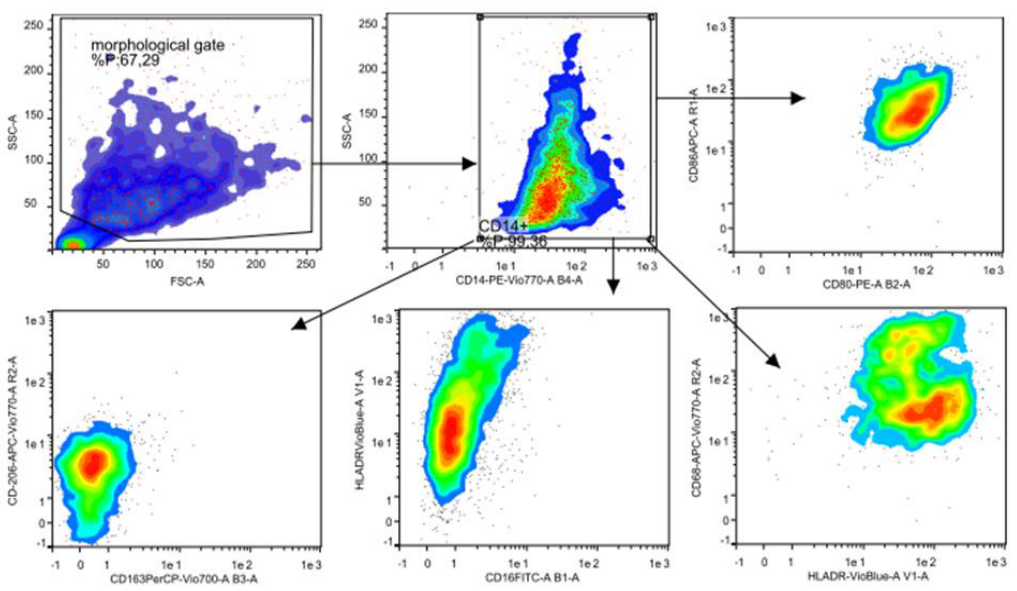
Figure 4. Gating strategy used for the analysis of M1 and M2 phenotype. For the analysis of human macrophage differentiation phenotype, cells were harvested and analyzed by flow cytometry. Morphological gating (top left) was used to exclude cell debris from analysis. The CD14+ monocyte differ from CD14-, in order to identify macrophages, CD14+ cells were identified (top middle). Next, CD14+ cells were analyzed for their expression of CD80 and CD86 (top right red and yellow), HLA-DR and CD68 (bottom right light green and orange), CD16 and HLA-DR (bottom middle blue) and CD163 and CD206 (bottom left green/light blue). Median fluorescence intensity of each marker was extracted by using the FlowLogic software, low-auto fluorescent cells that strongly express MHCII and CD14+ hi, high-auto fluorescent cells are marked as macrophages.